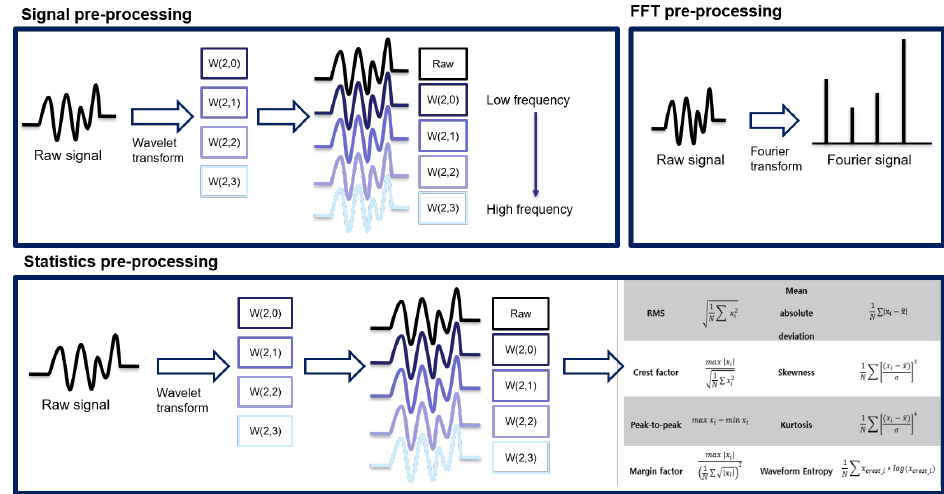
Figure 6. Preprocessing of each signal